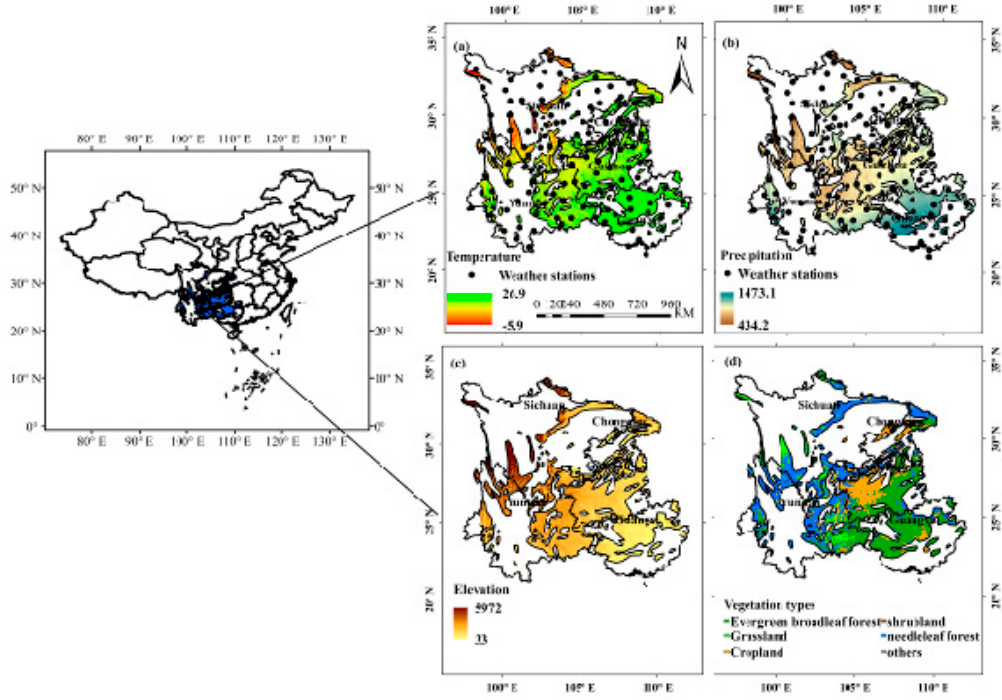
Figure 1. Location of the study area; and the spatial distribution of temperature, precipitation, vegetation types, elevation, and meteorological stations in southwestern China.